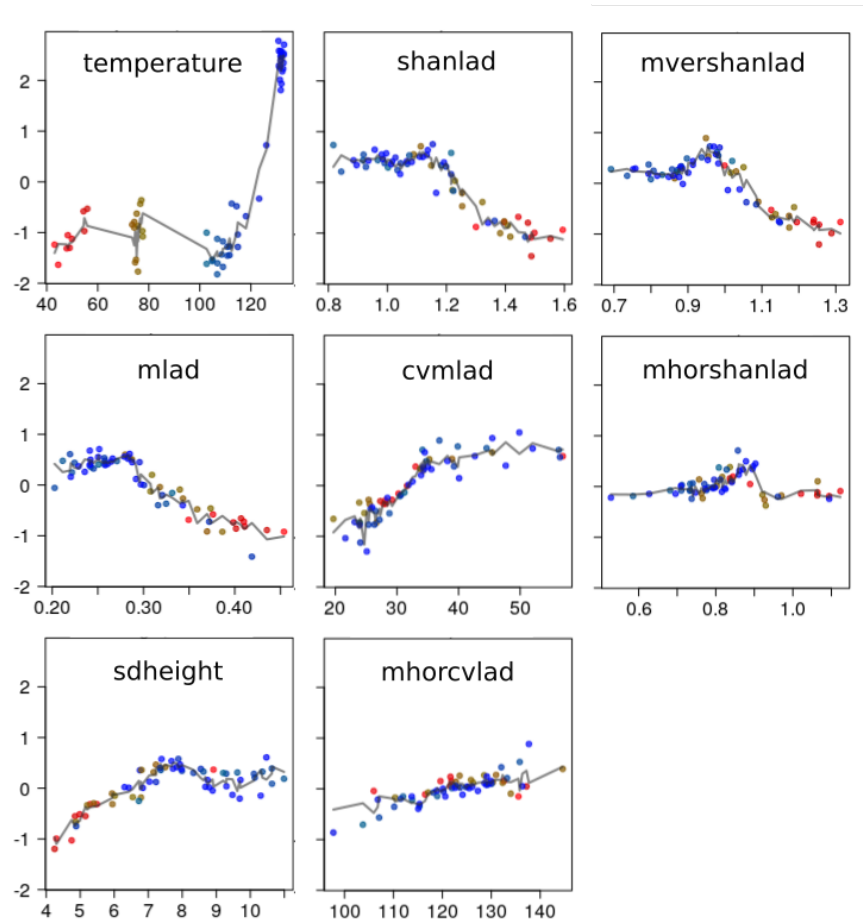
Figure 6. Feature contribution analysis for the top-seven variables model with mean annual temperature. Each graph represents the influence (intensity and direction, positive or negative) of a certain explanatory variable. The x -axis represents the value of the explanatory variable. The y -axis represents the feature contribution, or the change in predicted bird richness for a certain value of the explanatory variable. Color gradients help to visualize the interaction between mean annual temperature and the lidar-derived metrics. The fitted line was estimated with a k-nearest neighbors function with Gaussian distance